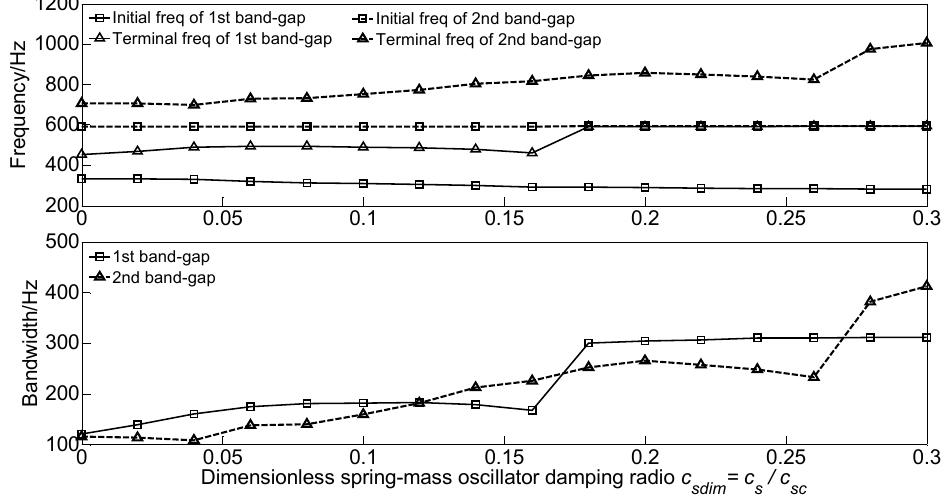
Figure 7. Band gaps maps as functions of dimensionless lattice constant a dim.